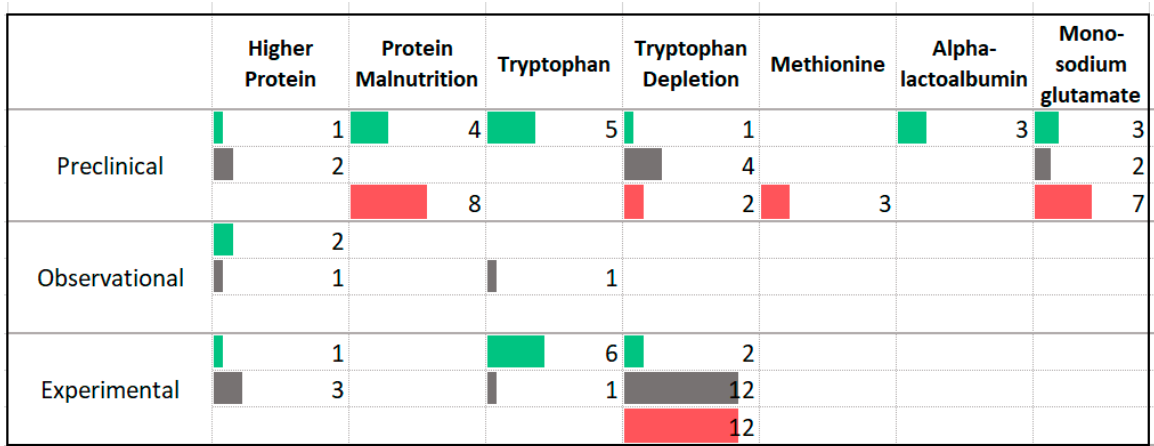
Figure 8. Studies assessing protein and anxiety. █ Higher intake or levels associated with decreased anxiety. █ No association between intake or levels and anxiety. █ Higher intake or levels associated with increased anxiety.